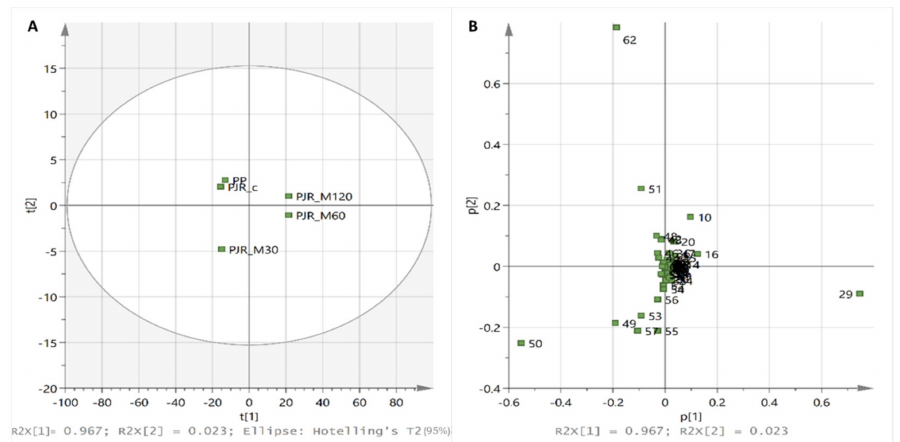
Figure 7. PCA scatterplots of RP-(C30)-HPLC-DAD data at 450 nm representing ( A ) the distribution of persimmon juice residue (PJR) samples according to t1/t2 score values and ( B ) the contribution of individual carotenoids to the scattering of PJR samples. Persimmon pulp (PP) was included as a reference for monitoring the changes in the native carotenoid forms of persimmon